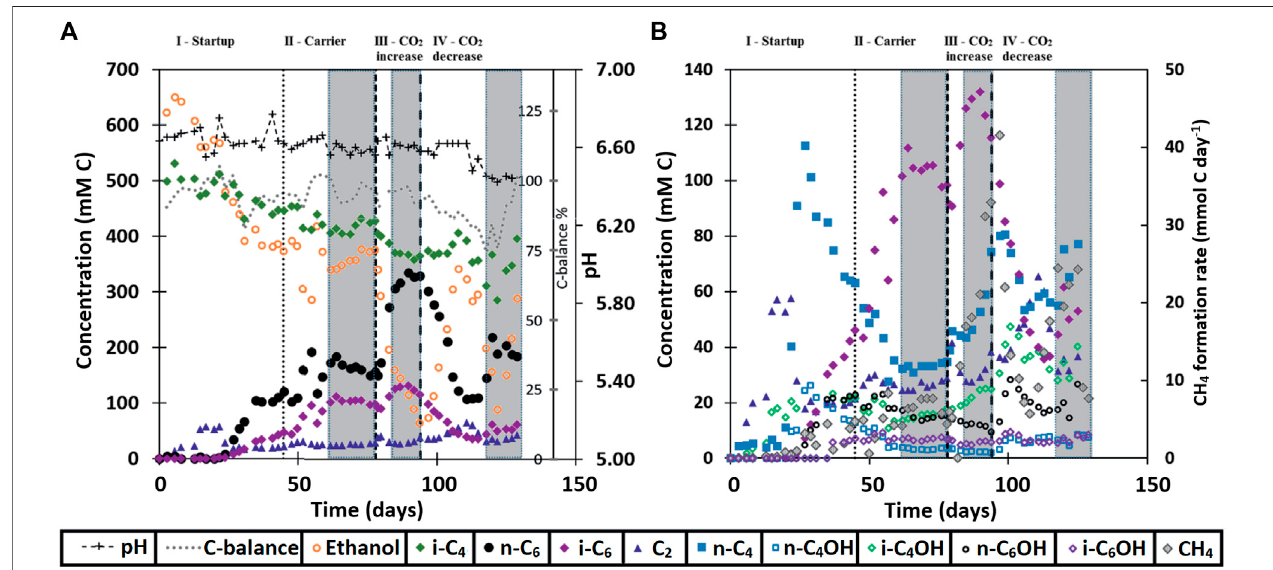
FIGURE 1 | Broth concentrations of metabolites within the continuous reactor system. Additionally, the carbon balance and pH are shown in (A) and methane formation is rate shown in (B) . The grey boxes at the end of each phase show the range where the averages were taken for the values in Table 5 .